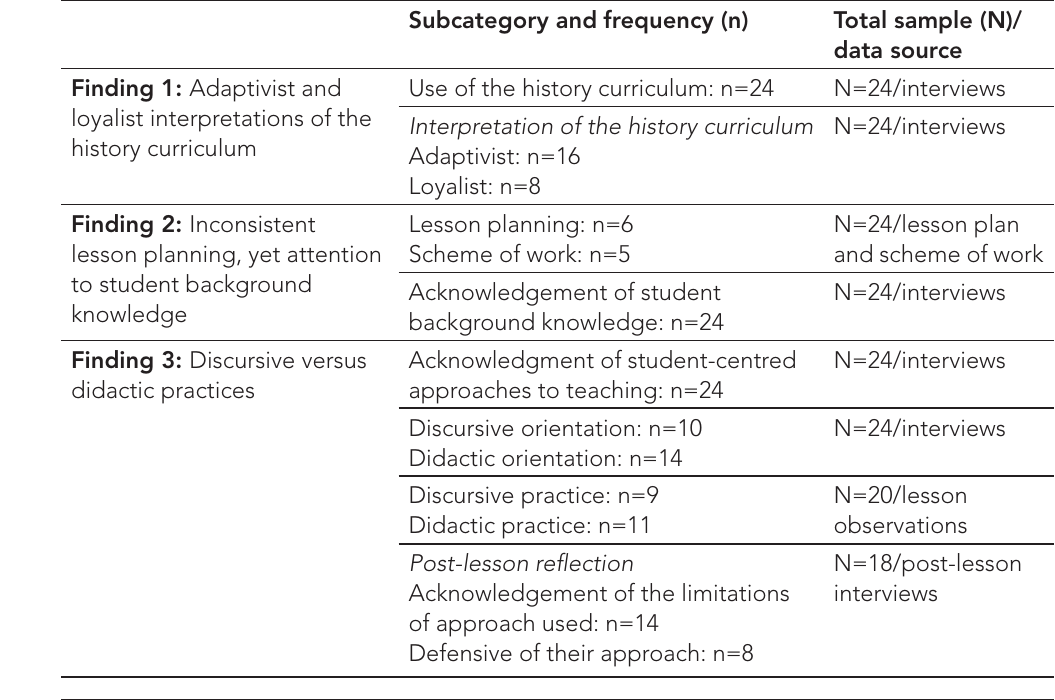
Table 1: Descriptive overview of the categories of analysis Subcategory and frequency (n) Total sample (N)/ data